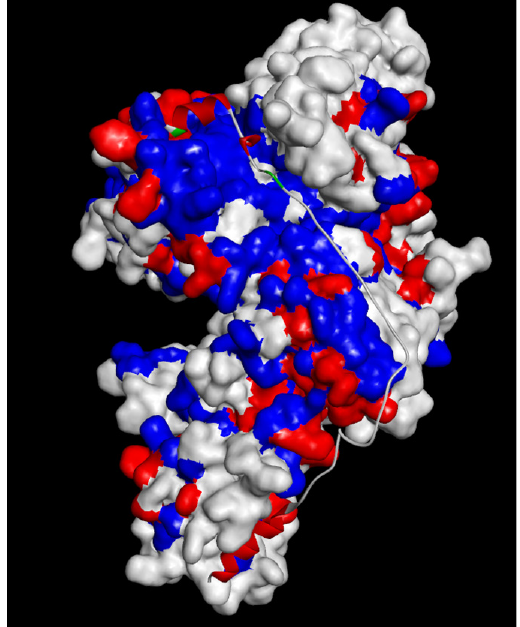
Figure 5. Analysis of residue conservation pattern in a CAPN group with protein structure to identify interaction interface (e.g., binding site of subdomain AB of CAST4). Trace residues may be conserved residues (blue), and class-specific residues for a CAPN group (red), or non-trace residues (white). For the Ca 2+ -dependent bovine CAPN1/CAST4 regulation system, the binding pockets of DI-DII and DIV are conserved sites, each of which subdomain A and B of CAST4 domain attracts site, in contrast to the DIII interaction surface provide class-specific and inter-variable specific sites among CAPN1 subgroup to the part of its subdomain